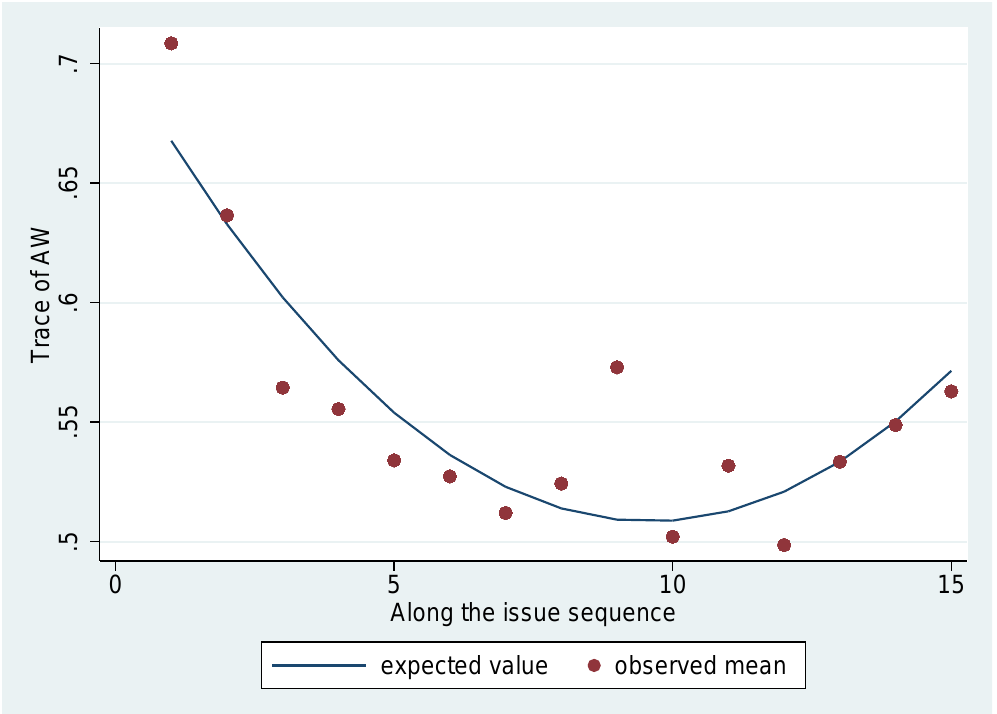
Figure 13: Evolution of the trace of AW , trace ( AW ) = ∑ n longitudinal design; STATA 12 xtreg implementation; n = 450. Plot of expected values based on the estimates β constant = 0.707 (s.e. = 0.031), p ≤ 0.001; β s = − 0.041 (s.e. = 0.009), p ≤ 0.001, β p ≤ 0.001; R-square (overall)